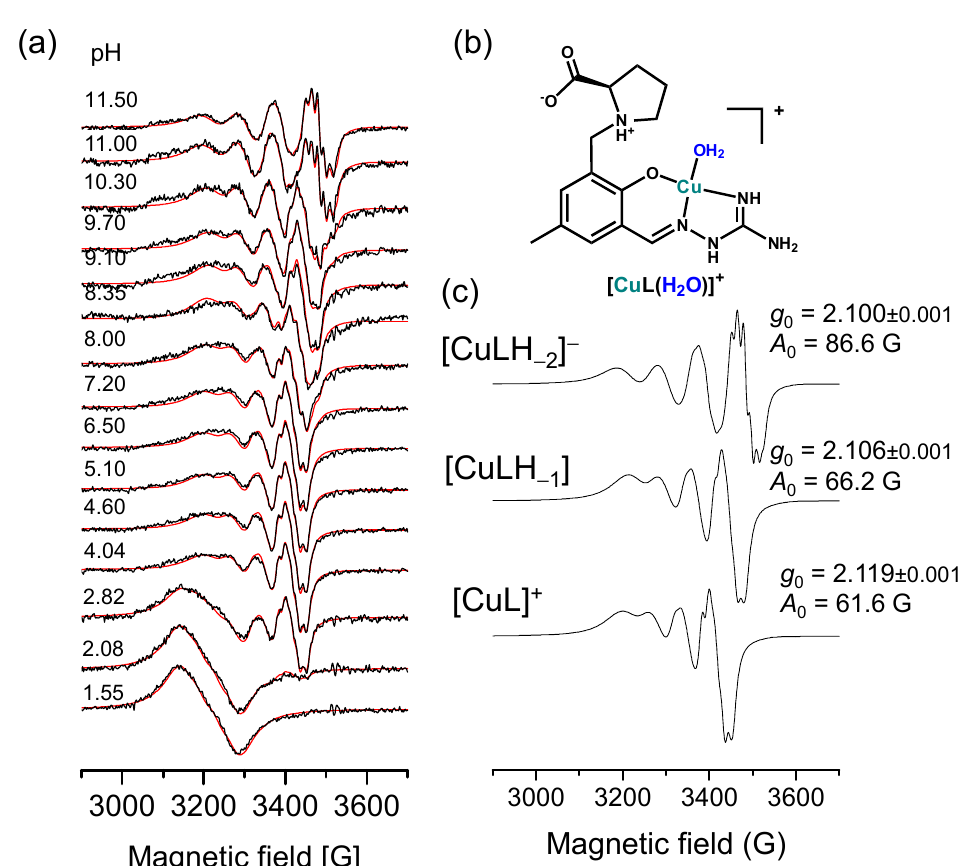
Figure 5. ( a ) Experimental (black) and simulated (red) isotropic EPR spectra recorded for the Cu(II)—Pro-SISC-Me (1:1) system in water at room temperature at various pH values; ( b ) Suggested structure of the [CuL(H 2 O)]+ complex (the possible hydrogen bonding between the proline nitrogen and the phenolato oxygen is not marked in the figure as well as the coordinated solvent molecules in the axial positions); ( c ) The calculated component EPR spectra and the g 0 and A 0 values of the species. ( c ligand = c Cu(II) = 1.0 mM; I = 0.10 M (KCl)).